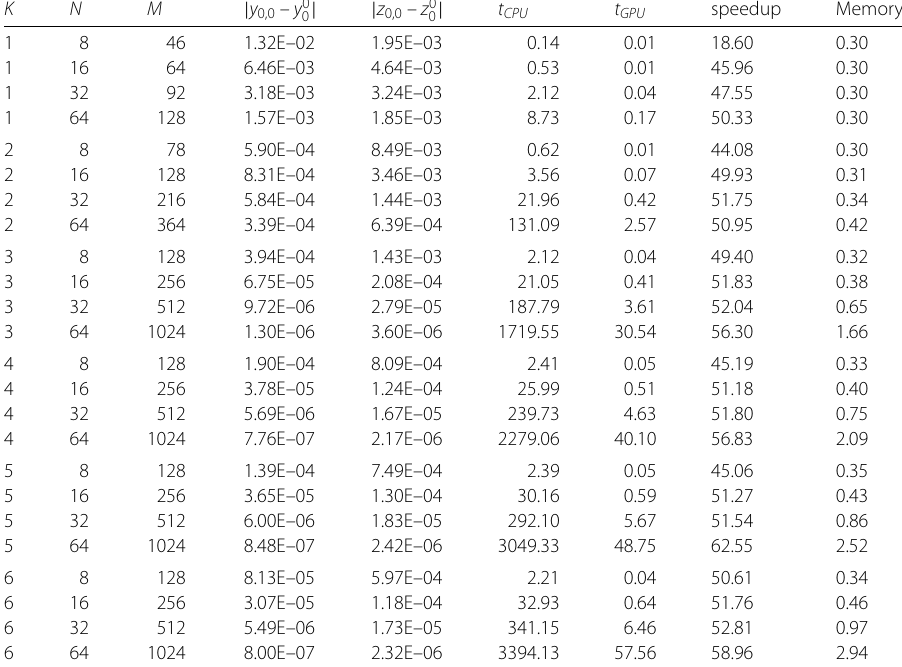
Table 9 The results for Example 4